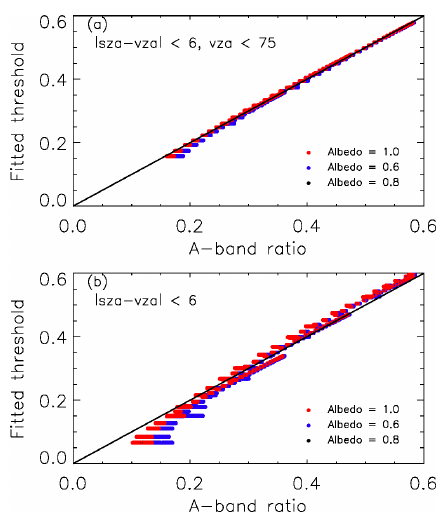
Figure 2. Scatter plot of model-simulated A-band ratios ( y axis) at surface albedo = 0 . 6 (blue), 0.8 (black), and 1.0 (red) versus com- puted with regression derived with the set of simulations at surface albedo = 0 . 8 ( x axis) for (a) view zenith angles <75 ◦ and (b) all view zenith angles. Absolute solar zenith angle and view zenith an- gle differences are smaller than 6 ◦ for both plots. The results are from simulations using standard US